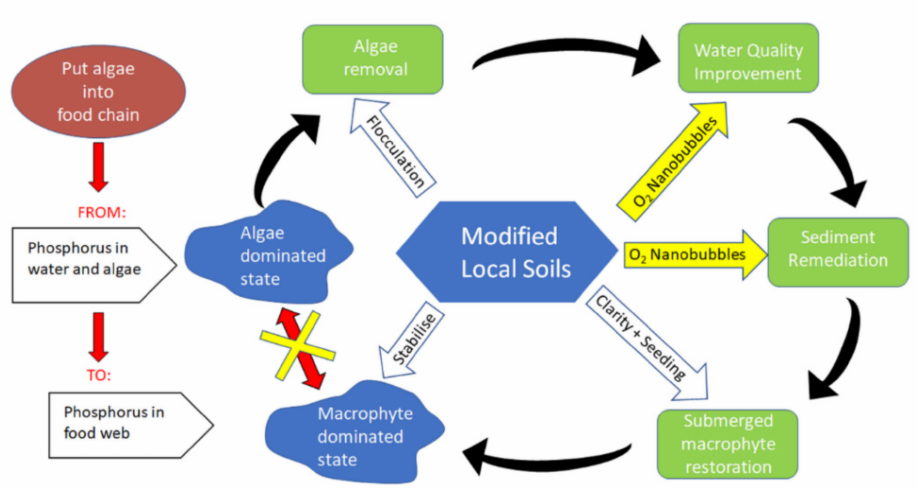
Figure 2. The use of oxygen nanobubbles in conjunction with modified local soils as a multi- disciplinary tool for lake restoration. Modified local soils provide a foundation for lake technologies which can be built on by such additional interventions as oxygen nanobubbles (yellow arrows) and macrophyte seeding. This system is aimed at providing a more holistic and long-term (yellow cross) transition from algae to macrophyte dominated lake-states. Adapted with permission from